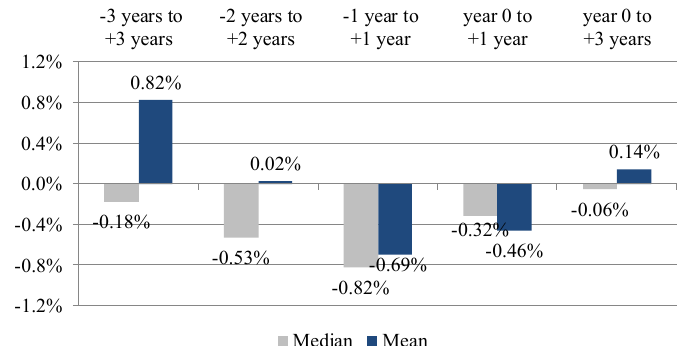
Fig. 5 - Values of the median and the mean (%) for the sample of changes in return on assets in selected time win- dows (measured in years). Source: Own